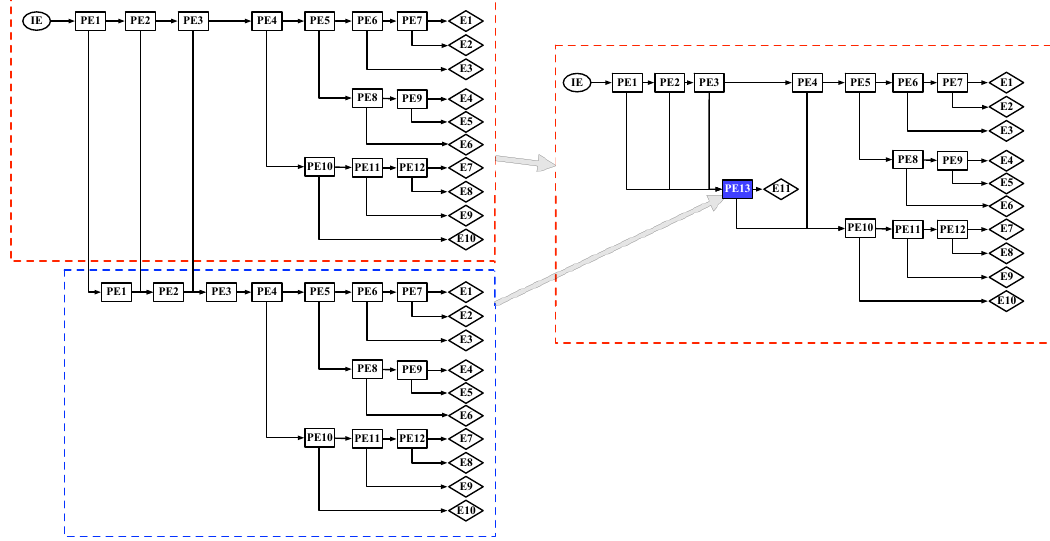
Figure 3. Multi-subject modeling and single-subject modeling of Ship collision accident.